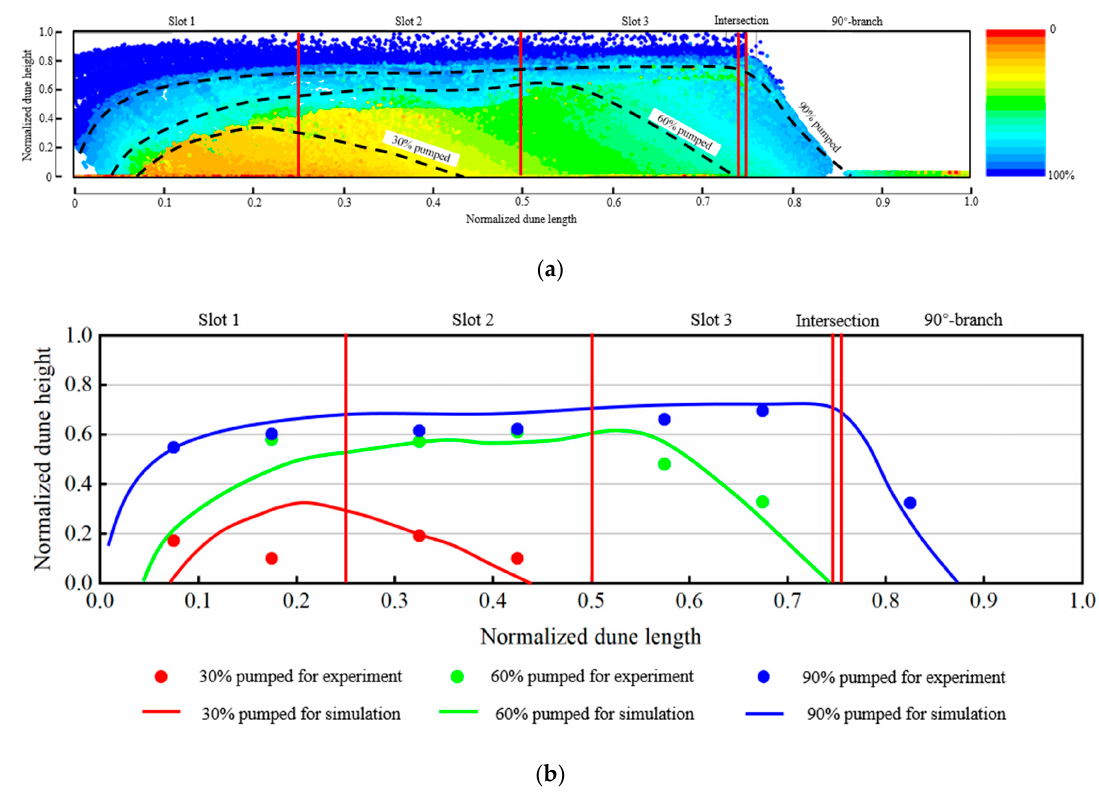
Figure 10. Simulation and experimental results of normalized dune height for case 1, ( a ) Dune geometries in different pumping stages, ( b ) comparisons between simulation and experimental results.